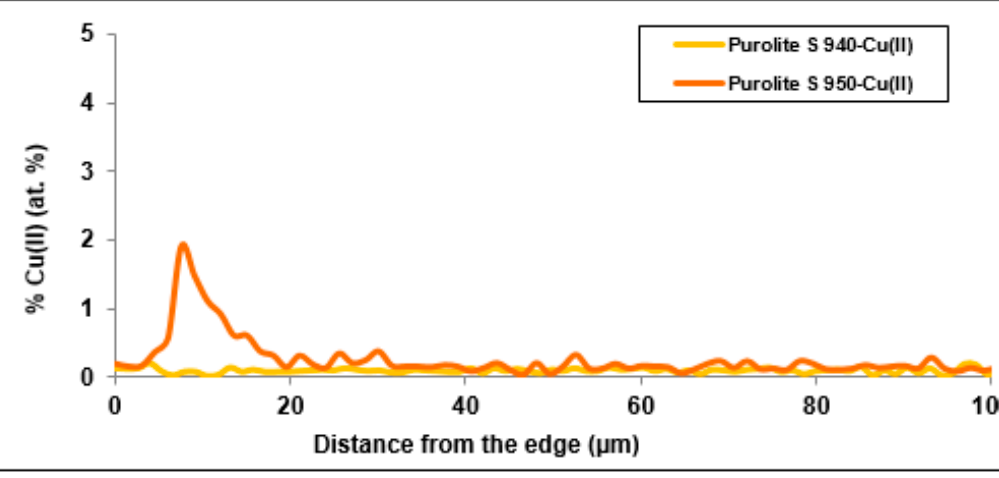
Figure 8. Distribution of copper ions in the cut beads of Purolite S 940 and Purolite S 950.